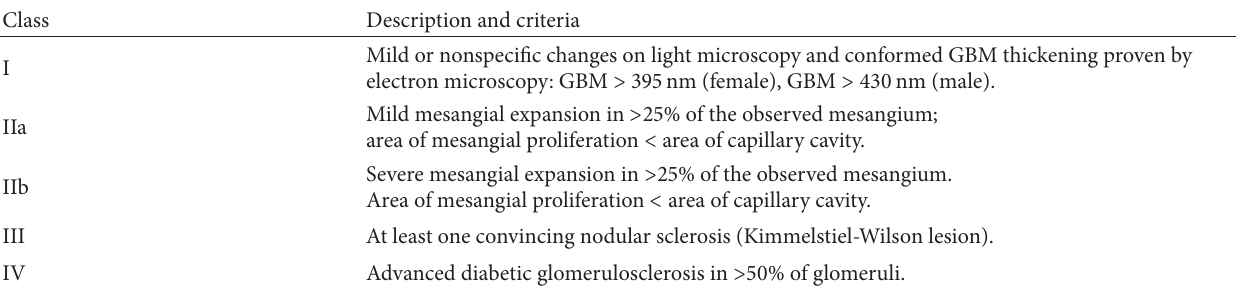
Table 1: Diabetic nephropathy is divided into four hierarchical glomerular lesions.